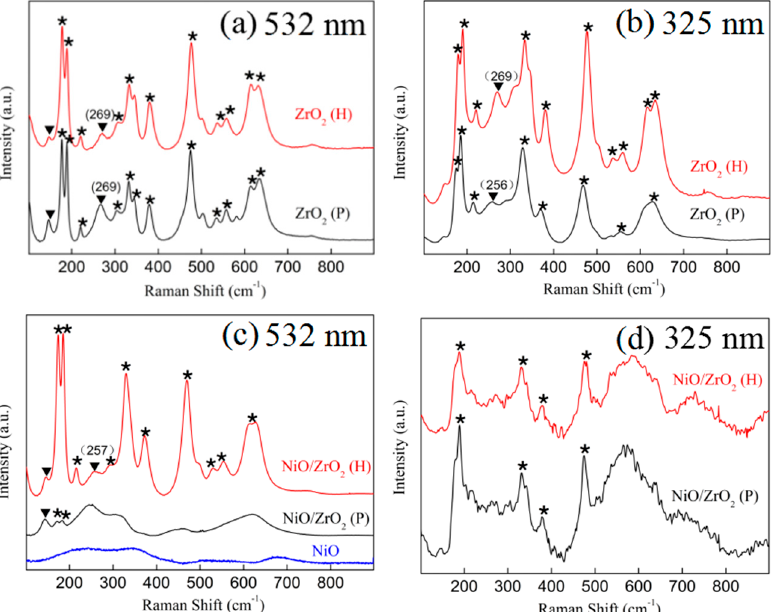
Figure 3. Raman spectra of ZrO 2 supports and NiO/ZrO 2 catalysts excited at 532 and 325 nm. ★ denotes monoclinic ZrO 2 ; ▼ denotes tetragonal ZrO 2 . ( a ) Raman spectra of ZrO 2 supports excited at 532 nm, ( b ) Raman spectra of ZrO 2 supports excited at 325 nm, ( c ) Raman spectra of NiO/ZrO 2 samples excited at 532 nm, ( d ) Raman spectra of NiO/ZrO 2 samples excited at 325 nm.